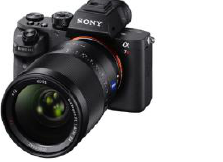
Figure 2. The exterior of SONY A7RII